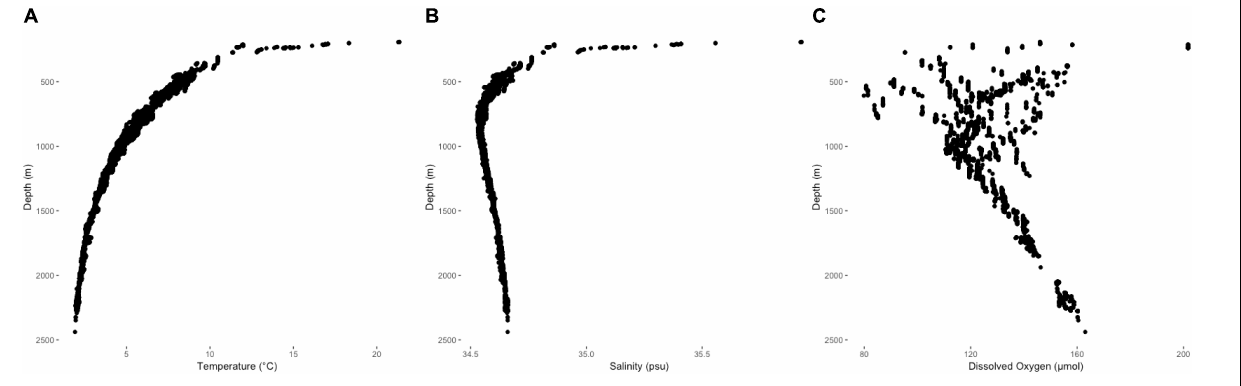
Frontiers in Marine Science |